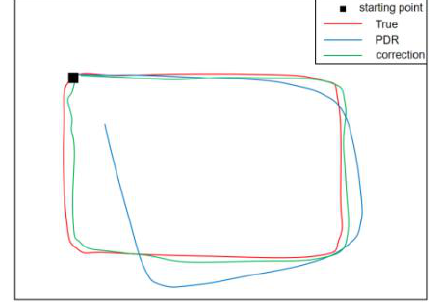
Figure 8 . Error trajectory